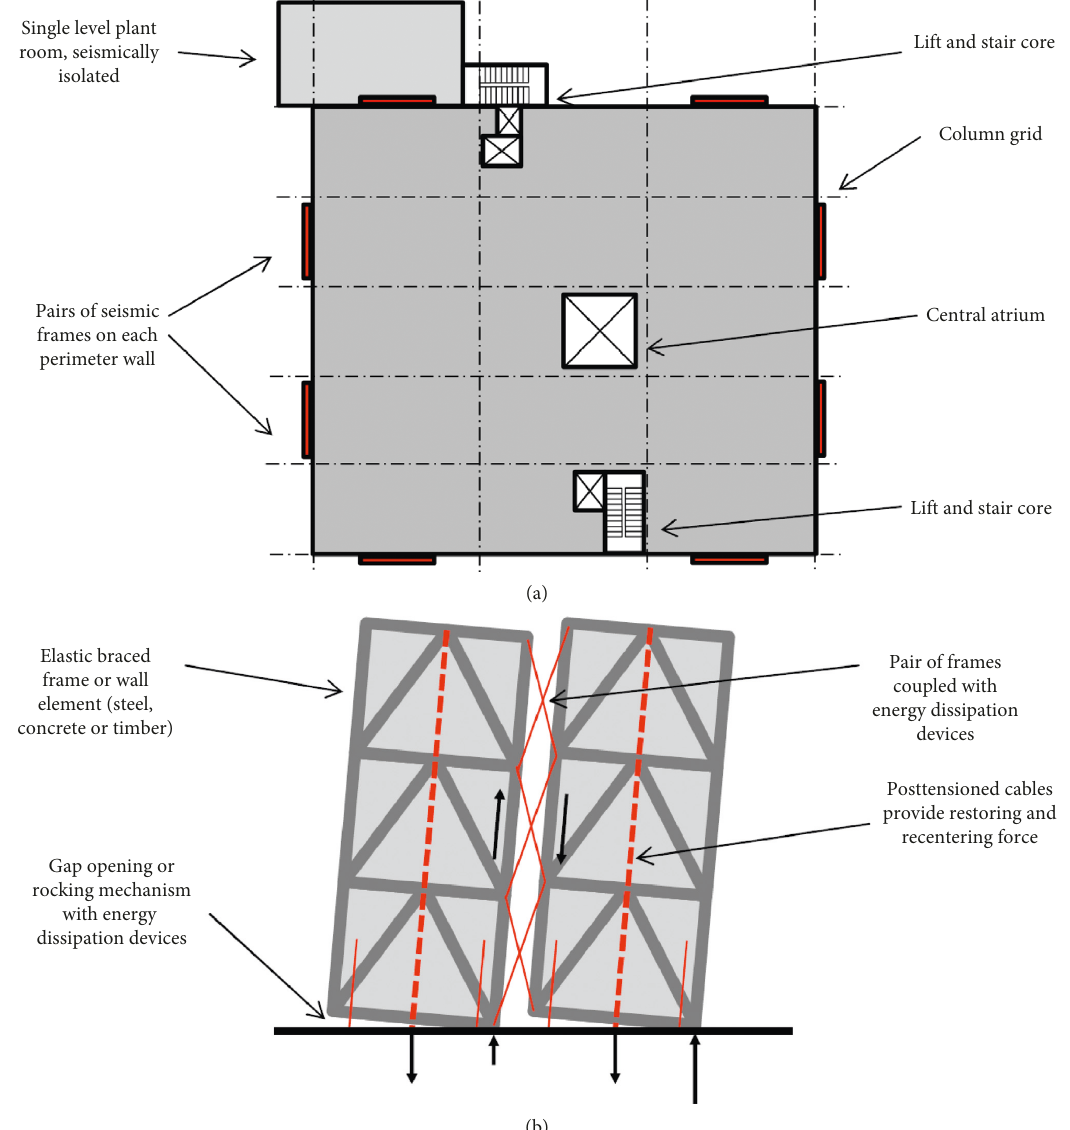
Figure 2: (a) Plan view of Kilmore Street Medical Center showing 8 pairs of rocking frames. (b) Each pair of frames has 12 HF2V devices mounted in pairs, with 8 at 4 points at the bottom of the frames and 4 at the 2nd and 3rd levels, where the diagonal lines at each level indicate added buckling-restrained braces